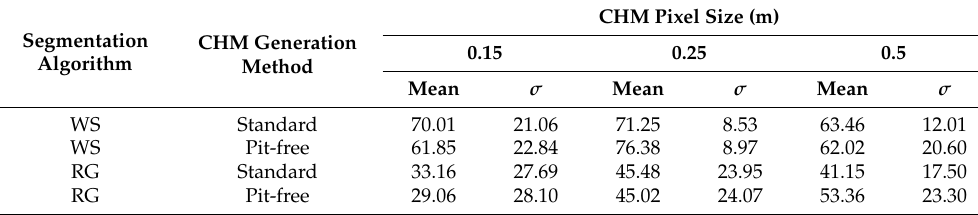
Table 11. The mean and standard deviation ( σ ) values for the successful delineation percentages produced from all sample plots at the three CHM pixel sizes (0.15 m, 0.25 m and 0.5 m), for each of the segmentation algorithm and CHM generation method combinations.